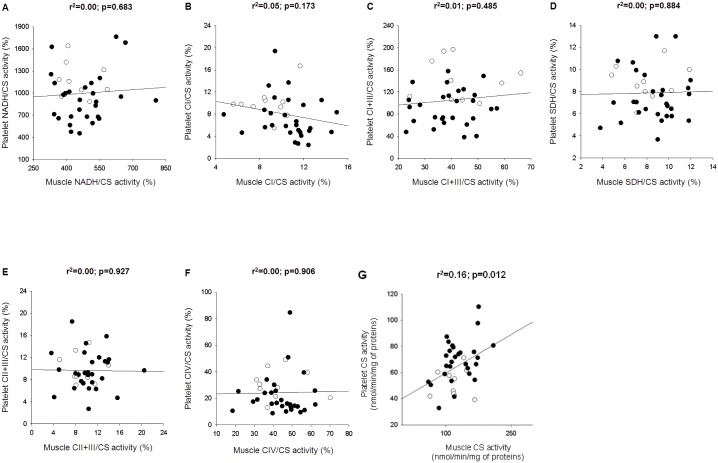
Relationship between platelet and skeletal muscle mitochondrial biochemistry.Mitochondrial biochemistry was measured on platelets (Y-axis) and triceps brachii muscle (X-axis) of ten surgical controls (white dots) and thirty patients with septic shock (<24 h from ICU admission) (black dots). Results of skeletal muscle mitochondrial biochemistry of two patients are not available due to technical troubles. Activities of nicotinamide adenine dinucleotide dehydrogenase (NADH) (A), complex I (CI) (B), complex I and III (CI+III) (C), succinate dehydrogenase (SDH) (D), complex II and III (CII+III) (E) and complex IV (CIV) (F) are expressed as percentages of citrate synthase (CS) activity (G). r2 and p values refer to Pearson product moment test.